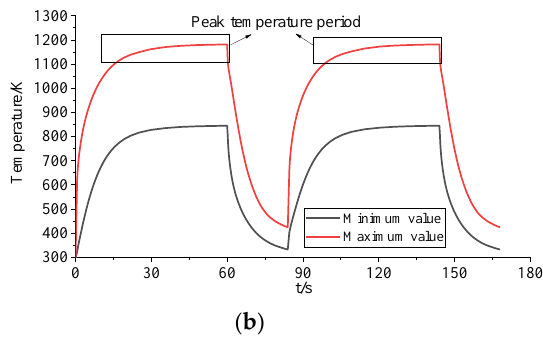
Figure 11. Variation trend and temperature curves with heating time. ( a ) Change of temperature contour with heating time; ( b ) Changing curves of maximum and minimum temperature.